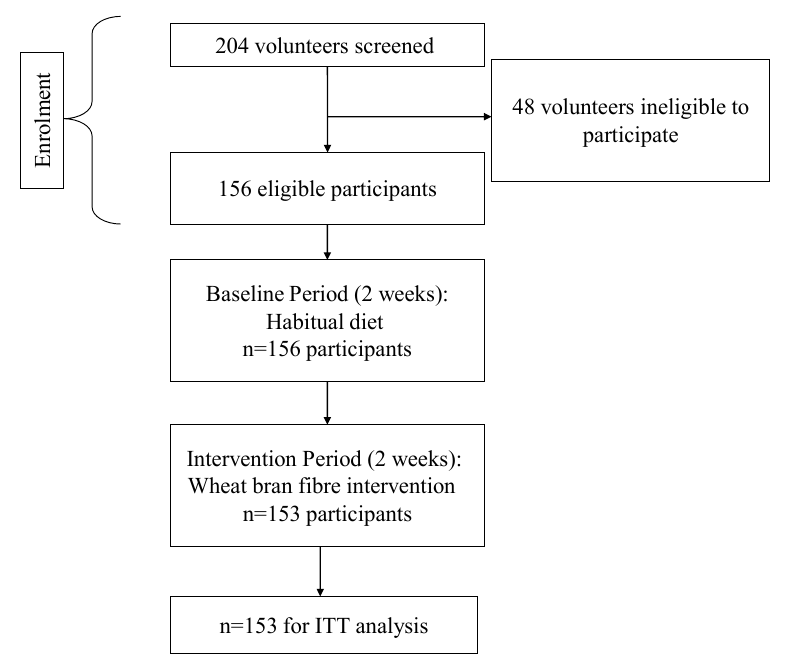
Figure 1. Consort diagram to show the flow of participants through each phase of the